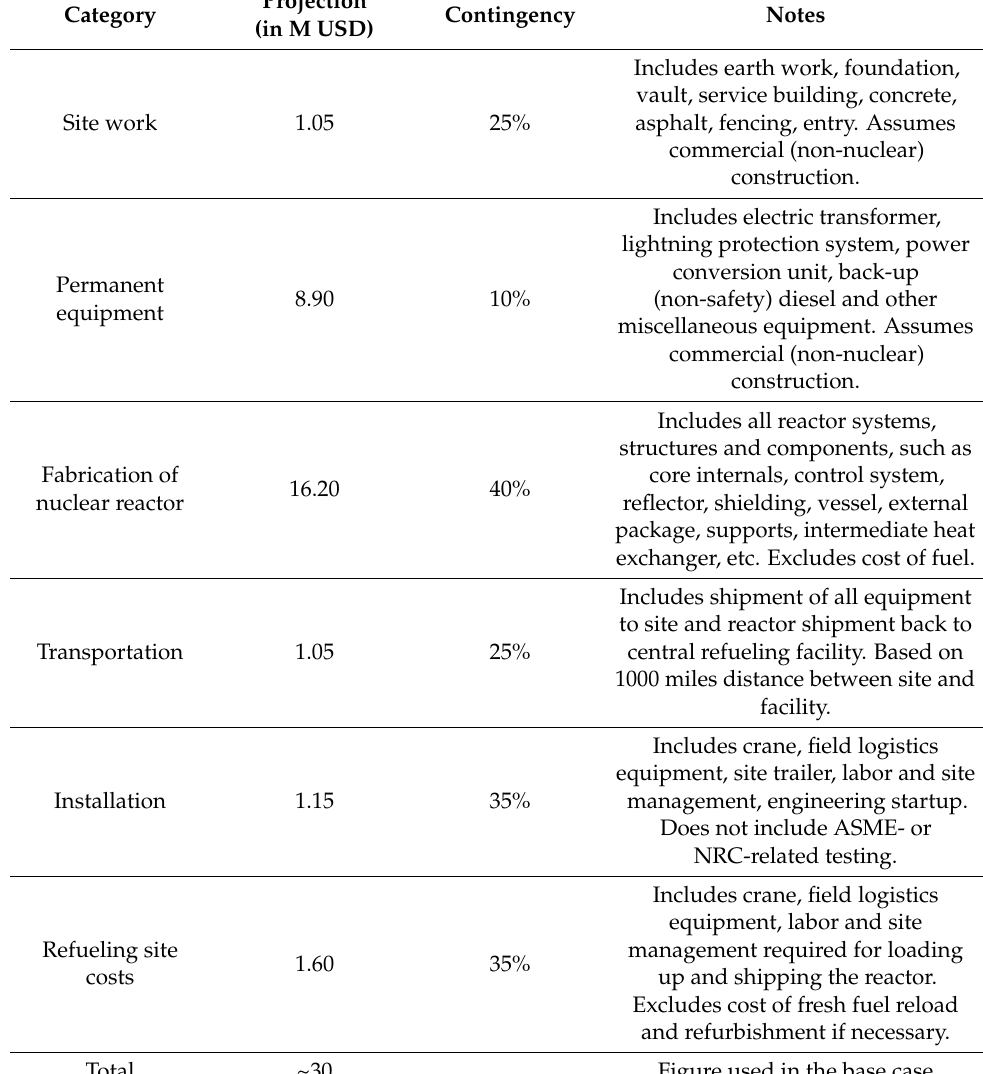
Table 4. Breakdown of NB capital costs, including